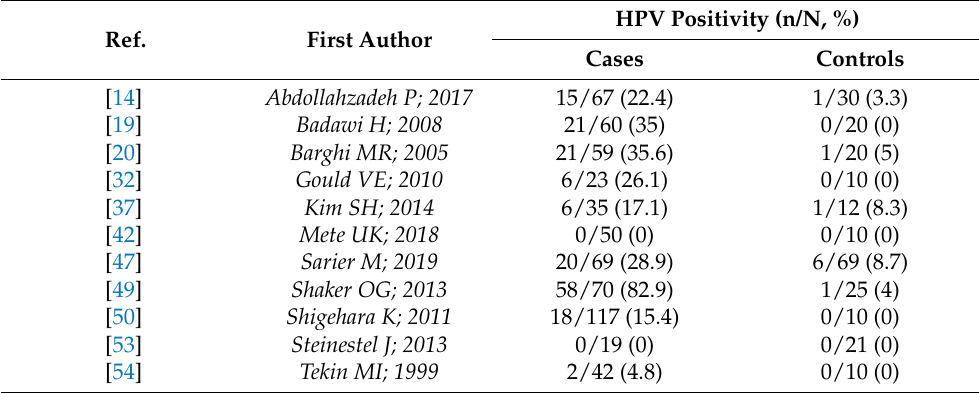
Table 5. HPV prevalence stratified by the presence (case) or absence (control) of any type of bladder tumor (case-control